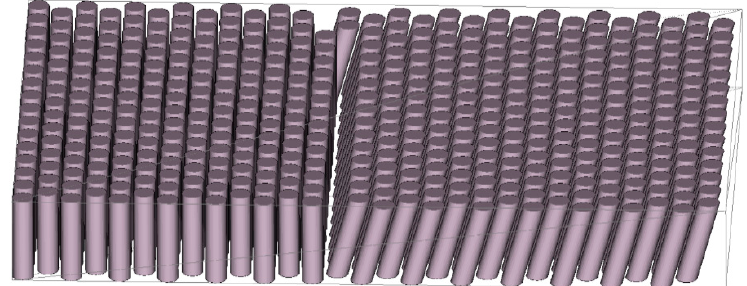
Figure 19. Arrangement of the CGx on BP_1_2-4 and